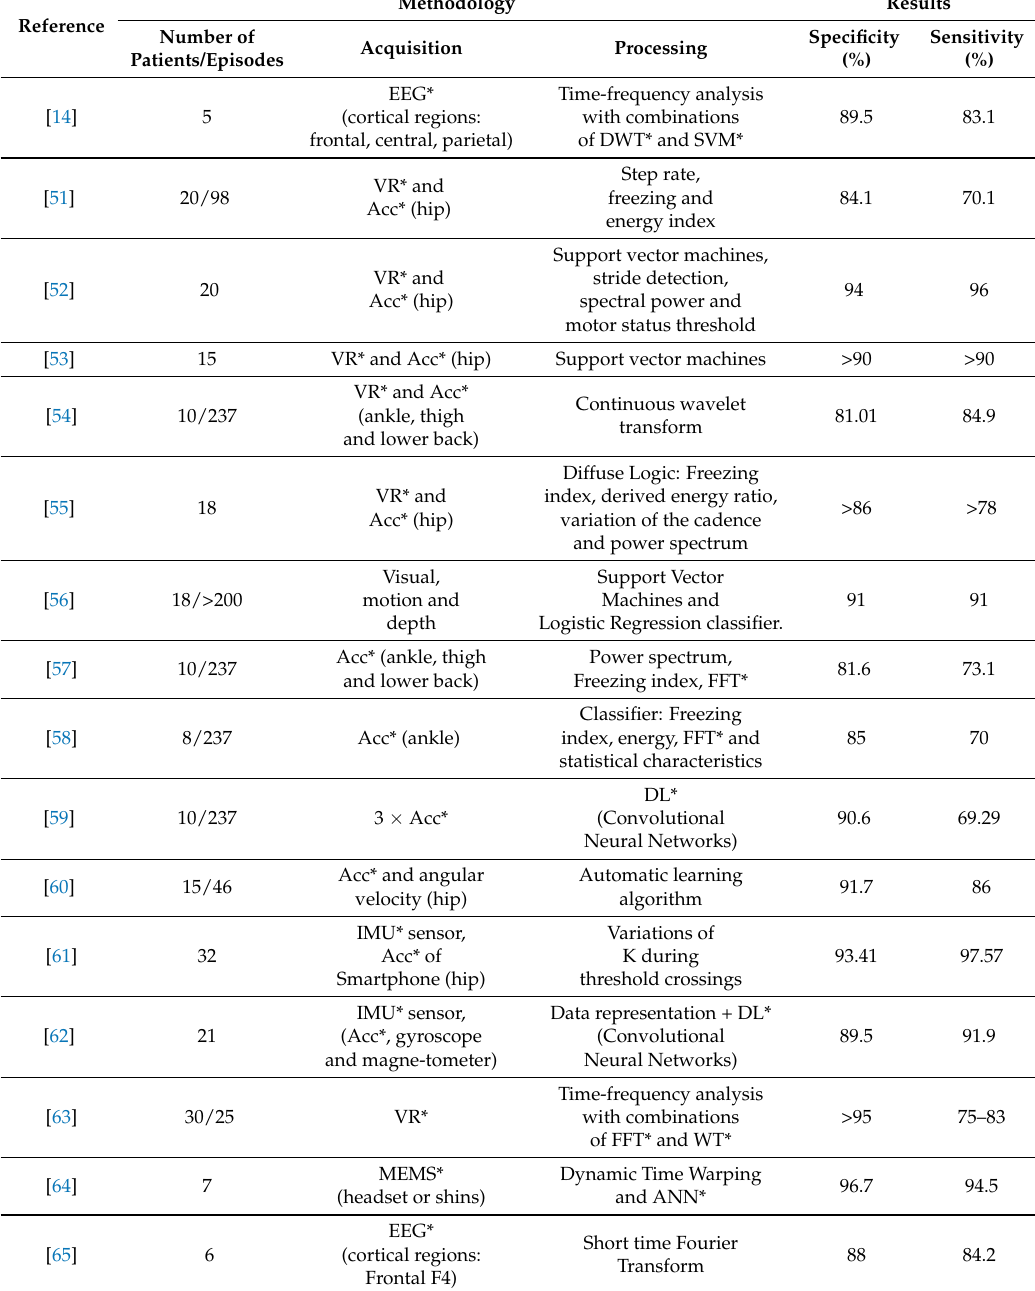
Table 6. Comparison of methodologies and results of work oriented to the detection of